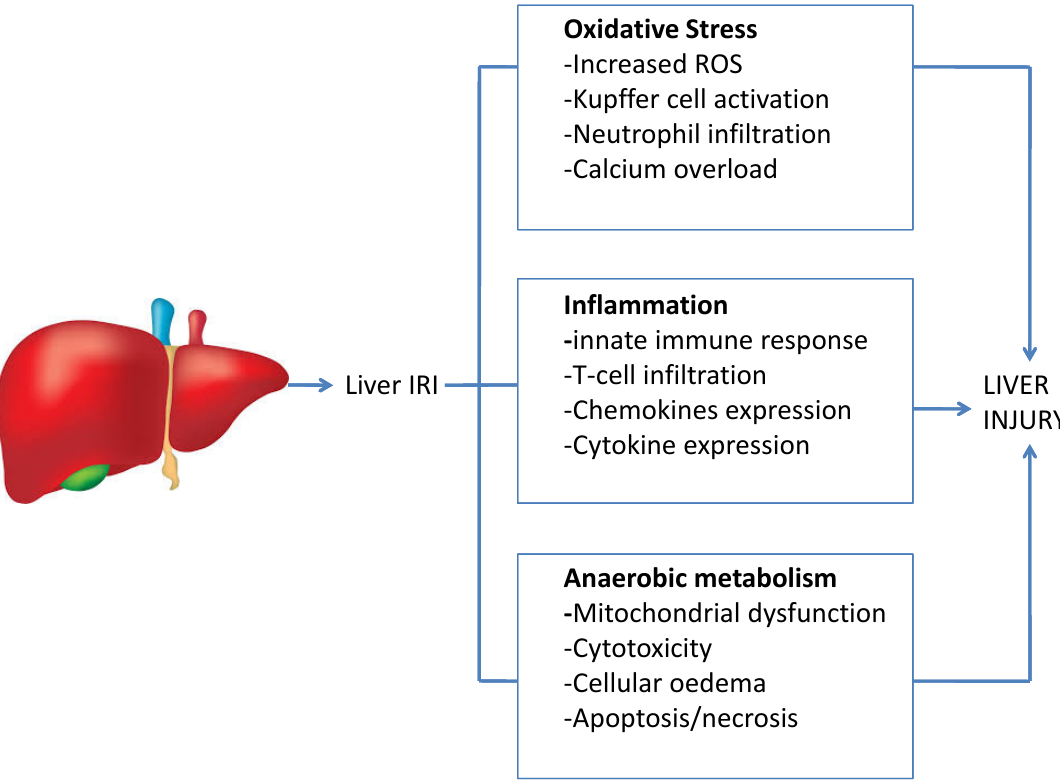
Figure 1. Liver ischaemia reperfusion injury. The scheme demonstrates the multifactorial nature of ischaemia–reperfusion injury (IRI) with multiple processes involved, which ultimately result in liver